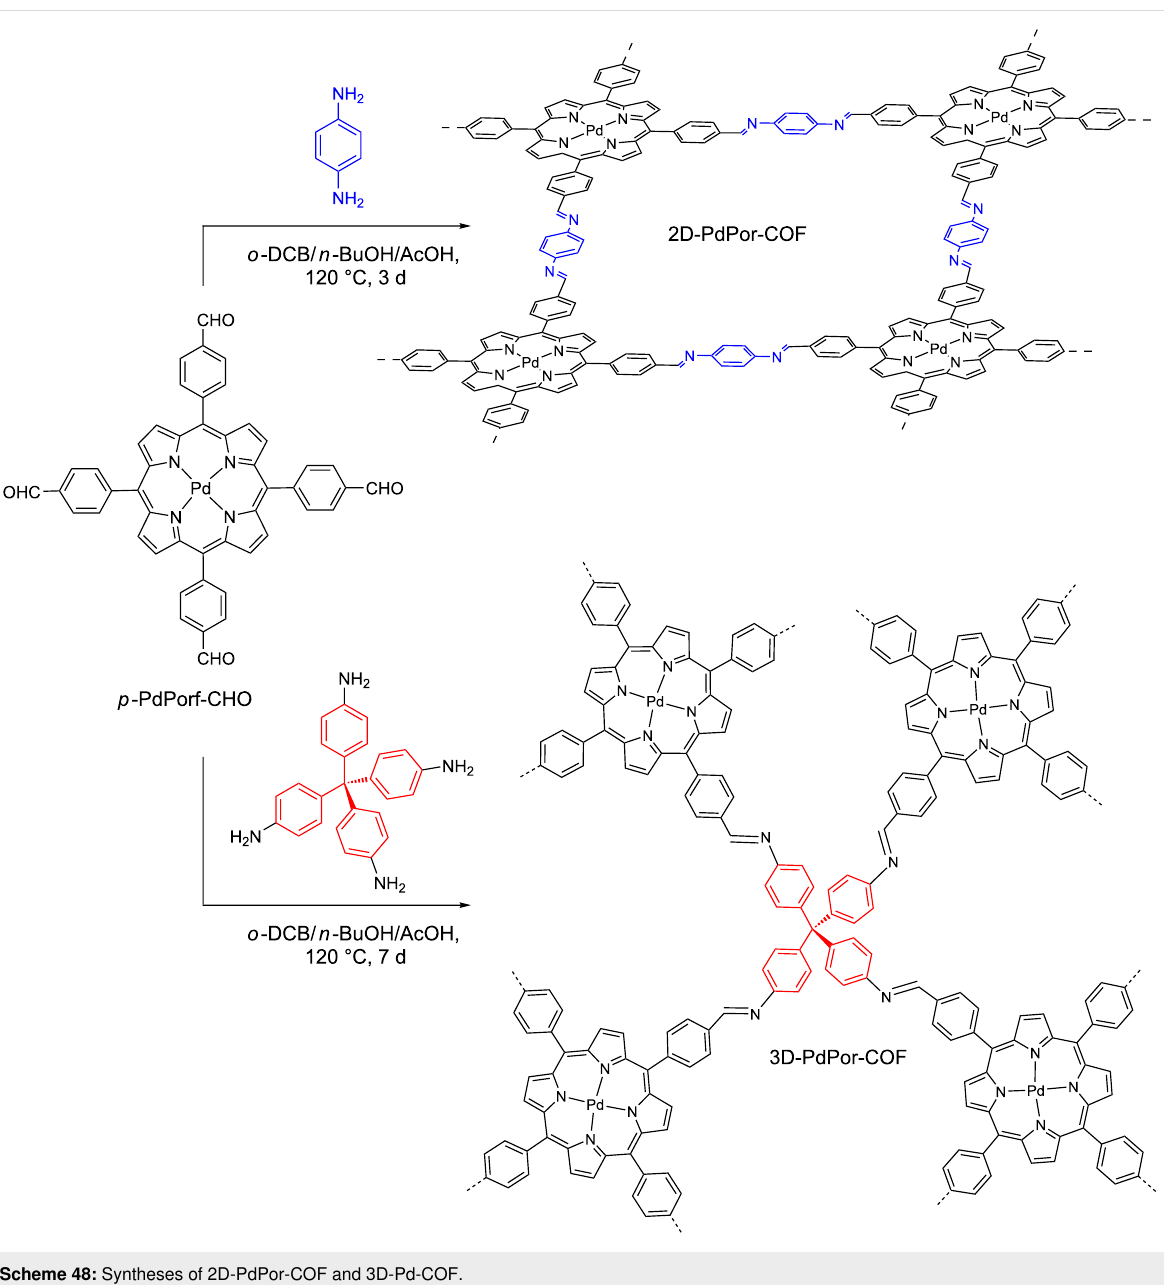
lower activity for the bigger naphthyl substrate (38%).